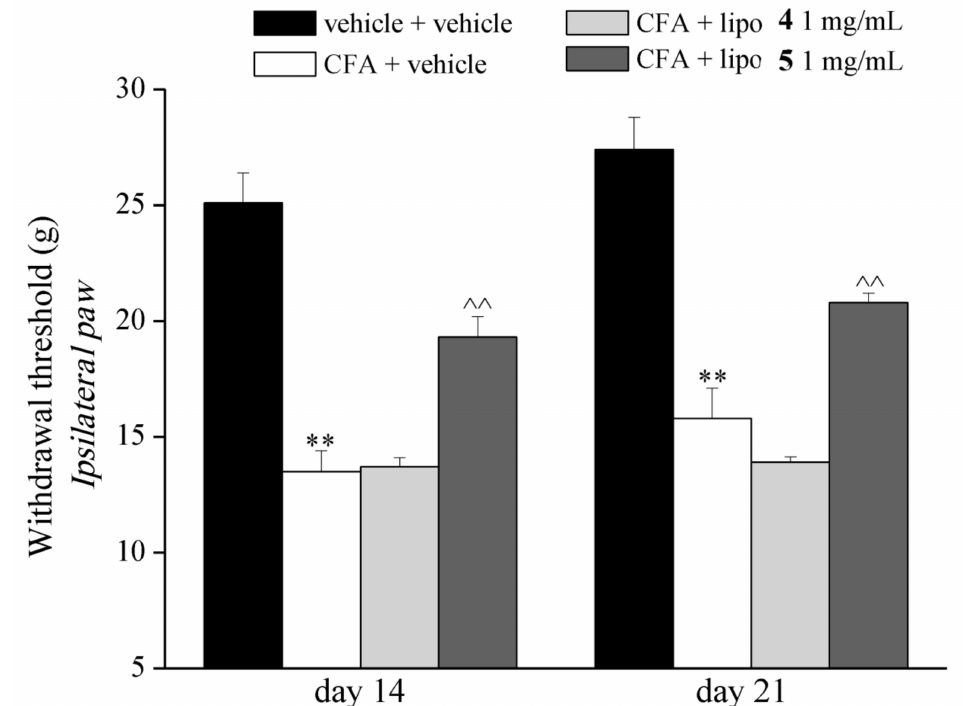
Figure 5. Intra-articular pain reliever e ff ect of lipo 4 and lipo 5 in a CFA i.a. injection-induced RA model in rats. von Frey test was used to assess the hypersensitivity toward non-noxious mechanical stimulus. Fifty µ L of lipo 4 and lipo 5 (both 1 mg mL − 1 ) were i.a. injected seven days after CFA. Measurements were performed on day 14 and 21. Control animals were treated with vehicle. The value represent the mean of eight rats performed in two di ff erent experimental sets. ** p < 0.01 vs. vehicle + vehicle-treated animals; ˆ p < 0.05 and ˆˆ p < 0.01 vs. CFA + vehicle-treated